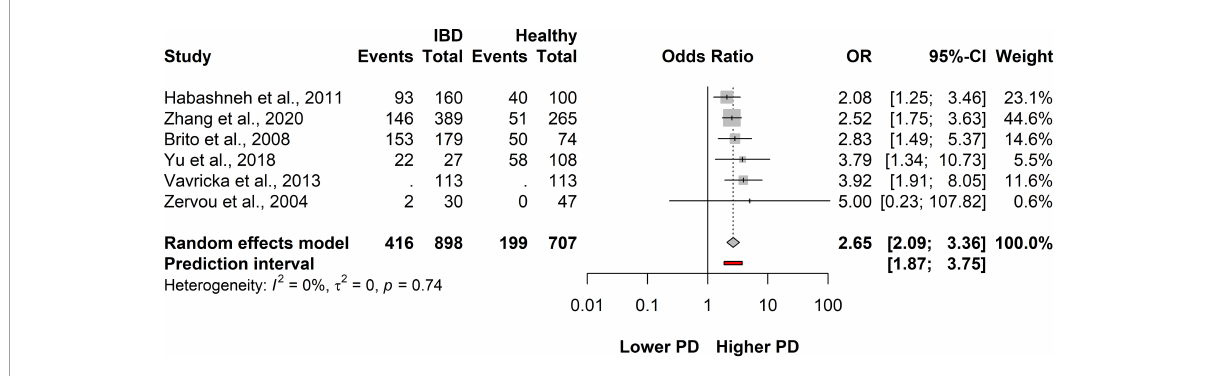
FIGURE2 Forest plot showing the odds of developing periodontitis in inflammatory bowel disease (IBD) and IBD-free